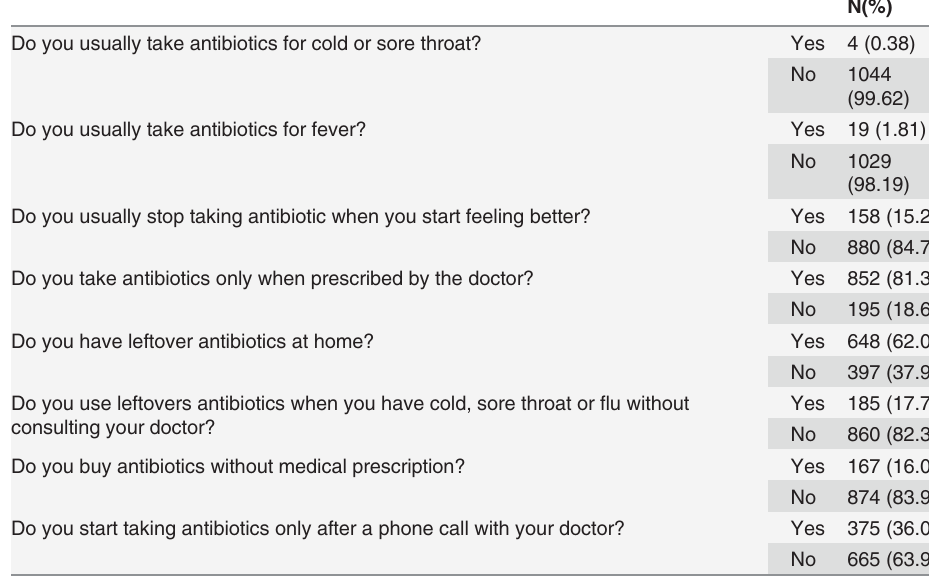
Table 2. Attitudes and behaviors about antibiotic consumption (N =